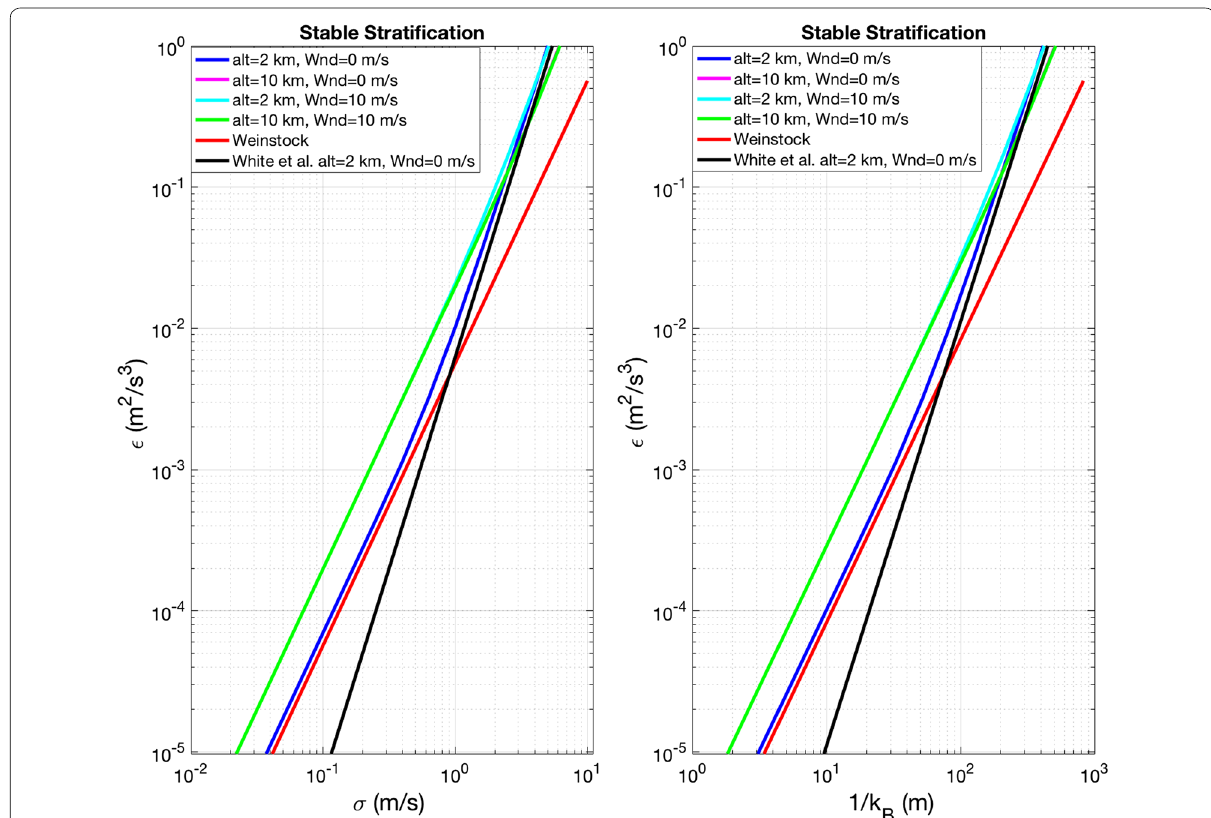
Fig. 3 Plot of the TKE dissipation rate ε against σ (left) and the buoyancy length scale L B (right) for various wind speeds and AGL altitudes. The black line is for White et al. (1999) formulation for zero wind speed and 2 km altitude. The red line is the Weinstock formulation. The numerical model results are: blue line for altitude 2 km, wind speed 0 m/s, cyan line for altitude 2 km, wind speed 10 m/s, magenta line for altitude = = = = wind speed 0 m/s, and green line for altitude 10 km, wind speed 10 m/s. Note that the cyan and magenta lines have essentially been = = = overwritten by the green